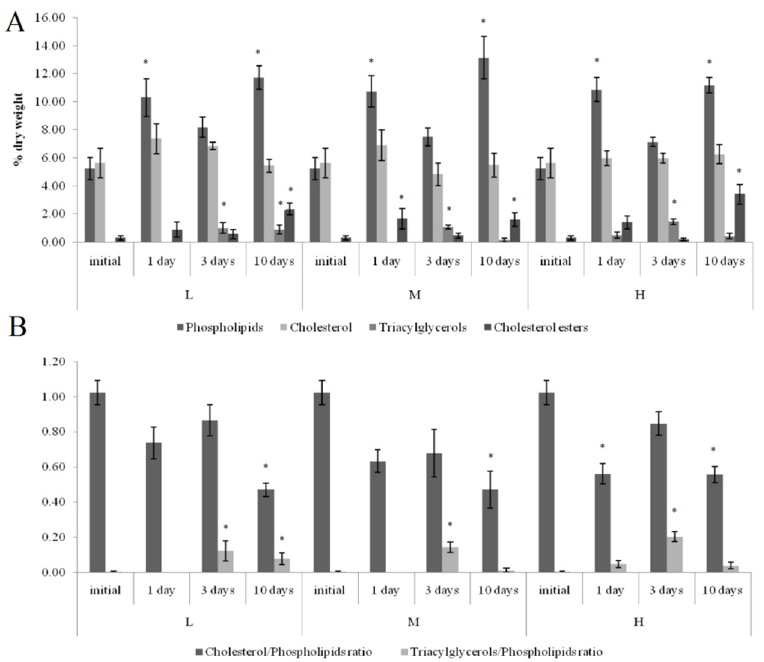
Figure 3. Lipid classes levels ( A ) and ratios ( B ) in the gills of horse mussels under low (L), medium (M), and high (H) crude oil concentrations. Values are means ± standard error ( n = 5). * significant results in comparison with initial level; 1, 3—significant results in comparison with the first and third days of exposure. Differences were estimated by the nonparametric Kruskal–Wallis test, p < 0.05 .